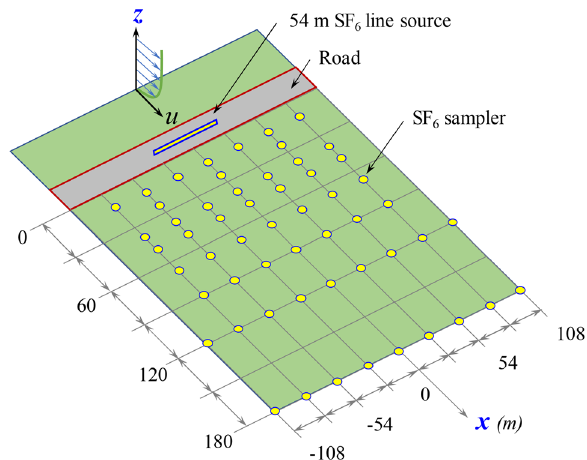
Figure 2. Illustration of the experimental setup implemented in the NTRS08 campaign in Idaho Falls, USA. In this study, we used the experimental results obtained without the